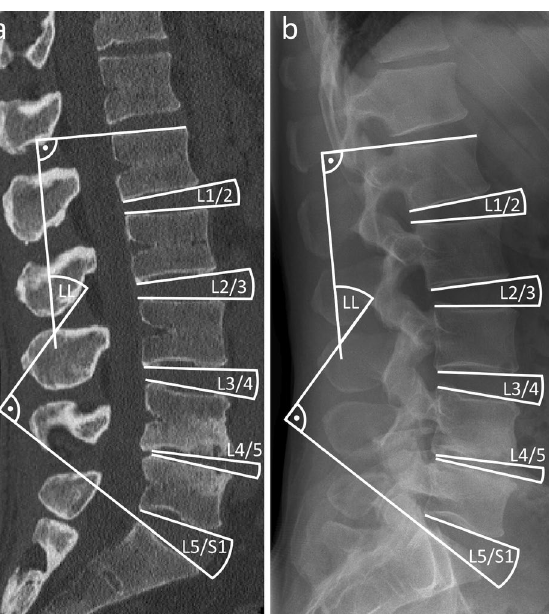
Manual registration of vertebrae is also based on projected contours. Individual vertebrae are aligned to the X-ray images in both planes, which can be simultaneously monitored through separate viewports. Translational and rotational operations are both permitted during this step. All vertebrae and the sacrum are aligned in this way (Fig. 3c and d). Contours are selected in both X-ray images for each vertebra and the sacrum. The contouring tool for this purpose allows the creation of contours based on control points. Between the control points, the contour line is ‘attracted’ to gradients in its neighborhood, thus facilitating quick and precise contour selection. If the edge is not detected automatically, straight lines and splines can also be drawn (Fig. 3e). Several contour sections can